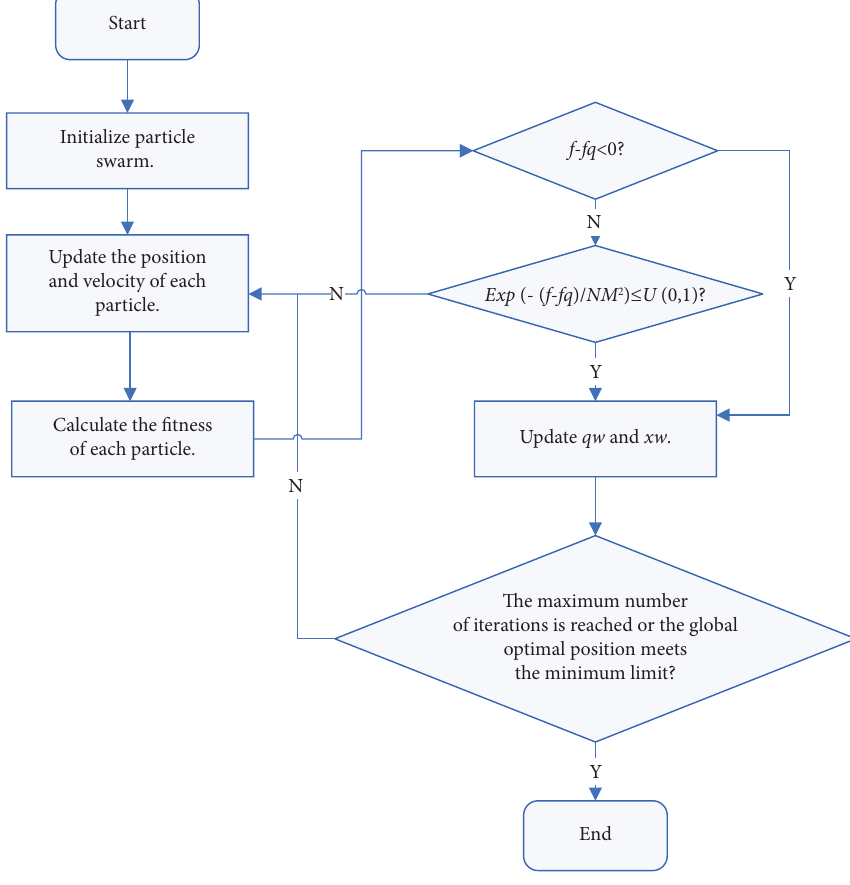
Figure 4: Improved particle swarm optimization process.